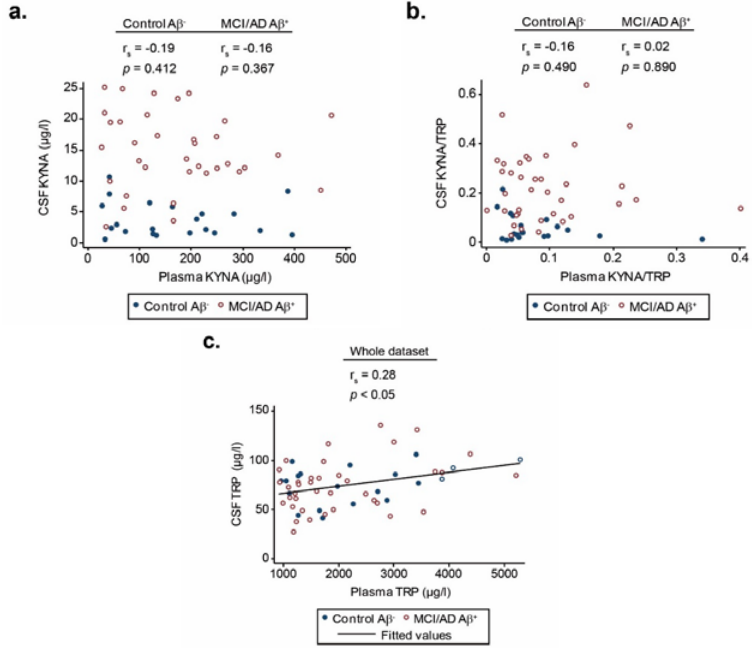
Figure 2. Spearman rank correlation between KYNA and TRP levels in plasma and CSF. Spearman rank correlation between KYNA ( a ), the KYNA / TRP ratio ( b ), and TRP ( c ) levels in plasma and CSF.